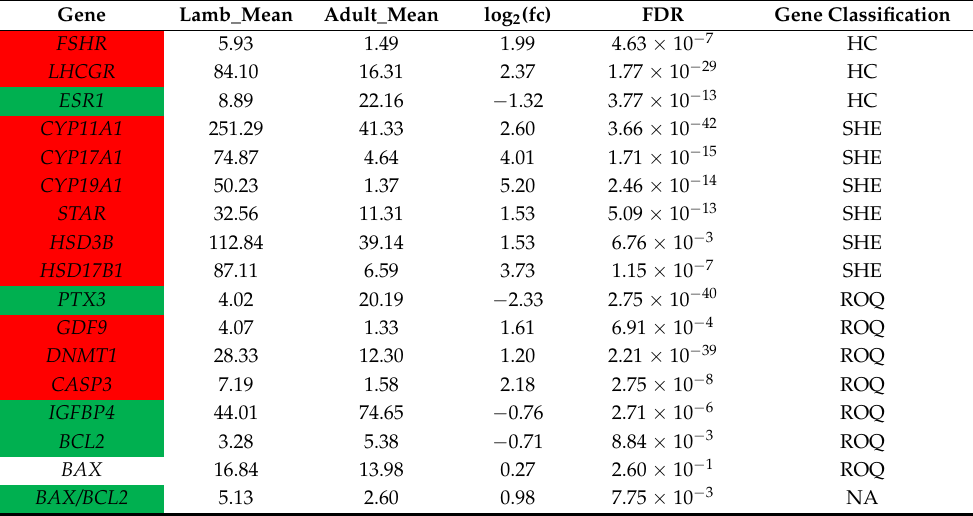
Table 3. mRNAs associated with hormone receptors, steroid hormone secretion and oocyte quality were differentially expressed in the lamb and adult sheep libraries.